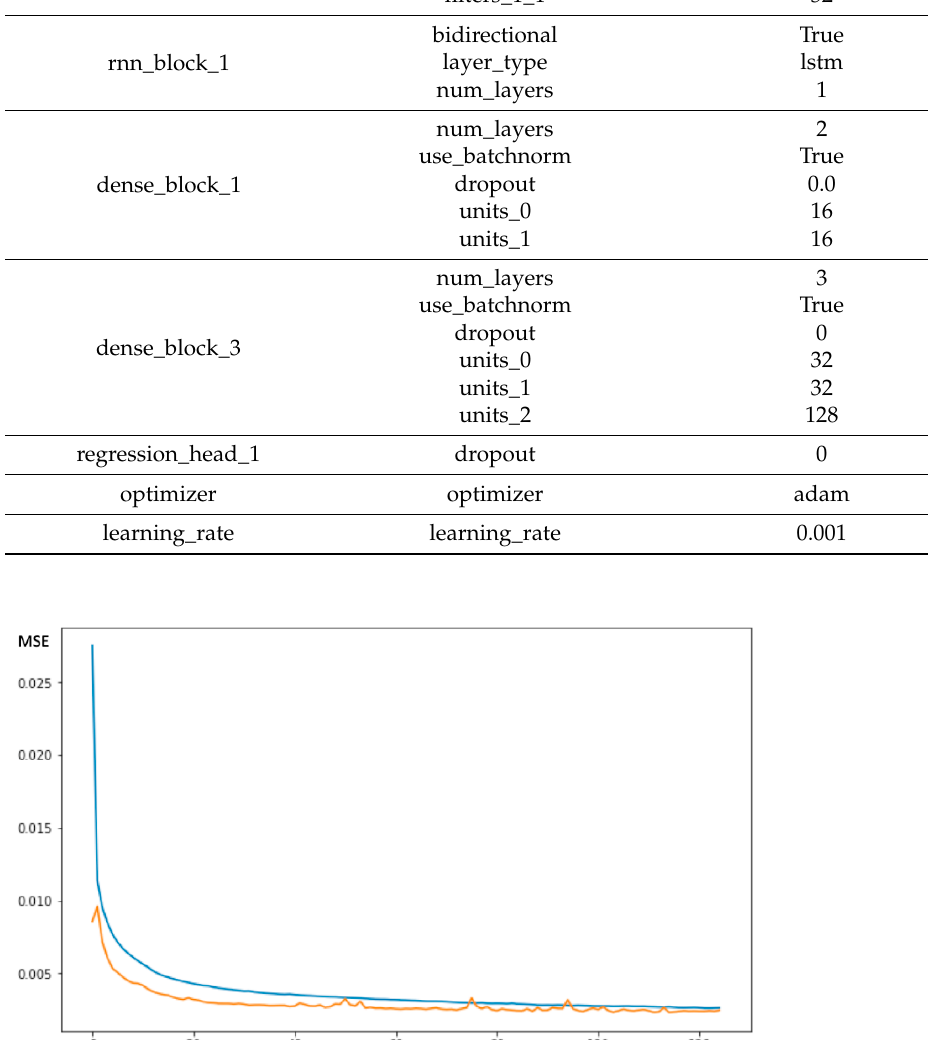
Figure 9. Training curves. X axis = epoch, Y axis = MSE, blue line = train MSE, orange line = validation MSE.